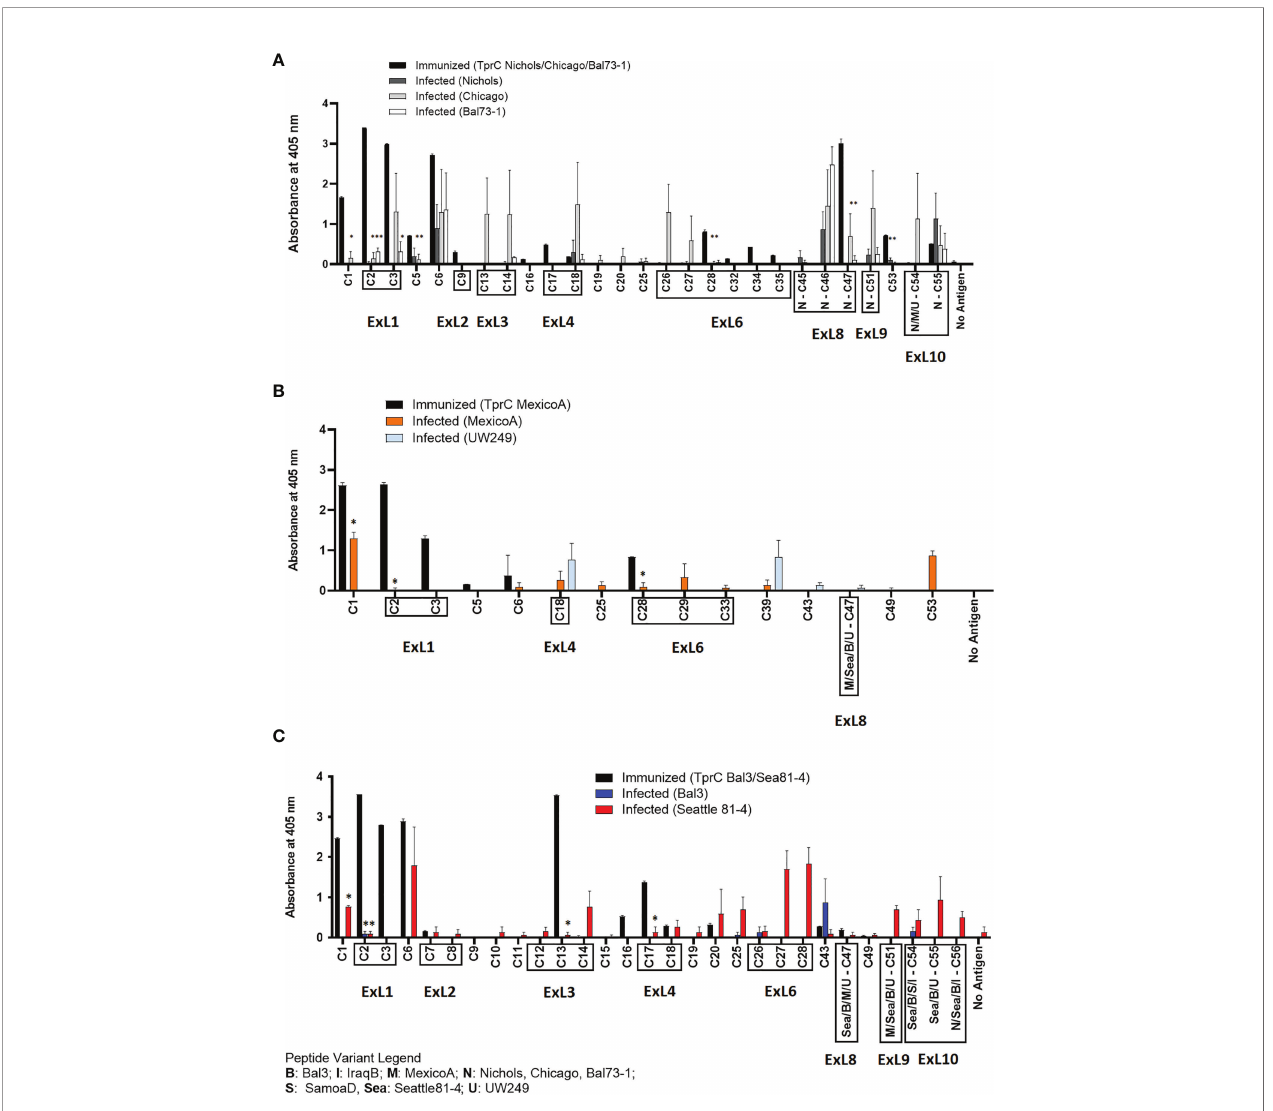
FIGURE 6 | Comparison of reactivity of sera from infected animals vs. immunized animals. (A-C) Reactivity to peptides following immunization with TprC variants compared to experimental infection. Data shown are means +/- SEM of 3 rabbits per group: 3 weeks post fi nal boost (immunized) and mean +/- SEM of values for days 30, 60, 90 post-infection (infected). Asterisk (*) indicates a signi fi cant difference in reactivity compared to the reactivity value following immunization. Peptides encompassing sequences predicted to be within ExLs are boxed. Strain names on x axes are abbreviated as follows: N, Nichols; M, MexicoA; Sea, Sea81-4; B, Bal3; U, UW249; S, SamoaD; I,